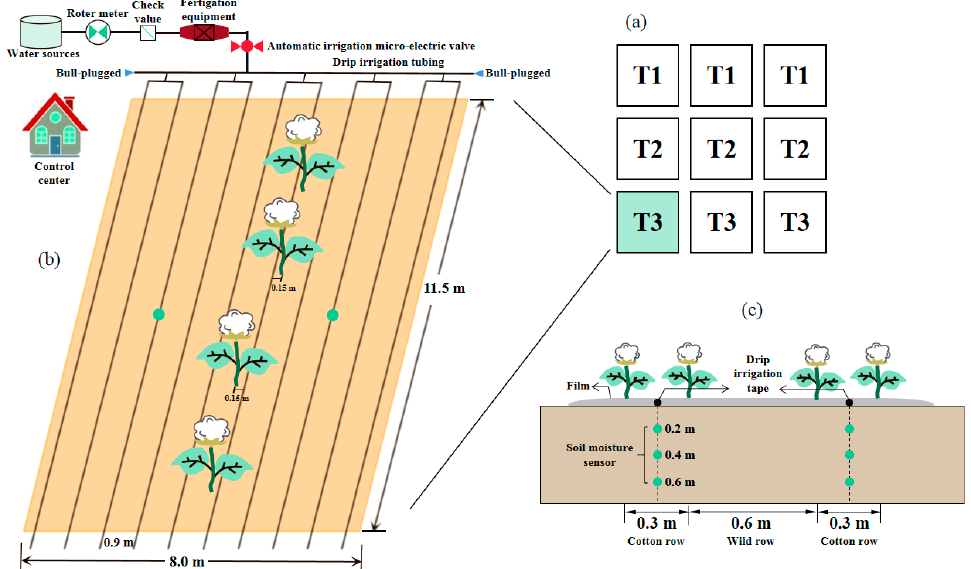
Figure 3. Depiction of the filed experimental design: ( a ) the experimental plot distribution under three irrigation methods (T1, T2, and T3), with three replicates; ( b ) a diagram of the T3 treatment, showing the system and its size; ( c ) a profile view of the cultivation pattern of the drip ‐ irrigated cotton used in this study, with sensor locations depicted. Table 2. Irrigation thresholds of automatic drip irrigation under mulch.